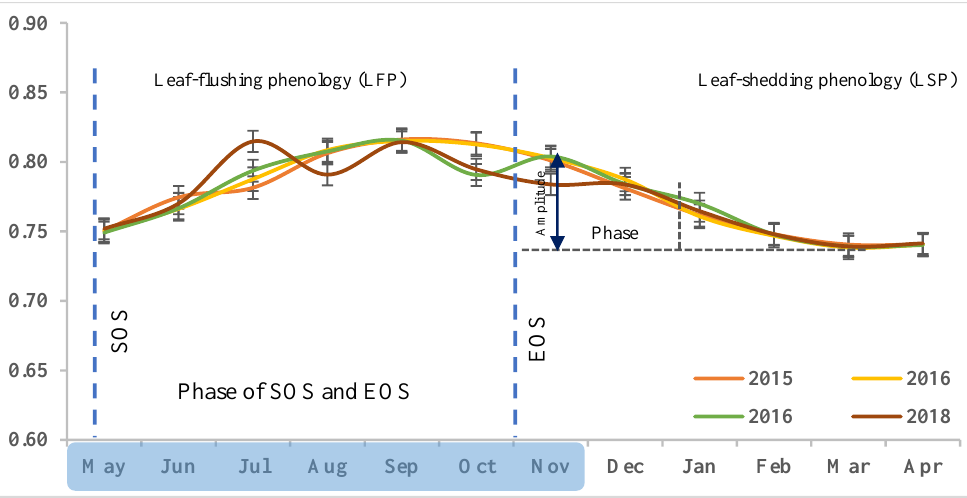
Figure 8. Fitted EVI profile of Landsat 8 OLI EVI composite data for evergreen forest. The average vegetation index profiles were generated from 10 geometry locations by assessing 40 profiles from 2015 to 2018. Figure 6 (bamboo), Figure 7 (rubber), and Figure 8 (evergreen) show the overlapping of average- fitted vegetation index profiles during SOS and EOS and the regular fluctuation of average EVI profiles of bamboo, rubber, and evergreen forest during the LSP stage (from December to April) in all 30 of the selected geometry locations from 2015 to 2018. The most distinguishable differences in the three vegetation cover indices were apparent in the LSP stage. The bamboo average-fitted vegetation index values were Min = 0.71 and Max = 0.83 from 2015 to 2017 and Min = 0.71 and Max = 0.84 in the LFP stage in 2018 (Figure 6). The fitted values for evergreen in the LSP stage reveal lower vegetation index values than those for bamboo in all selected phenology years (Figure 8). We found that evergreen had fitted average index values of Min = 0.63 and Max = 0.70 in the LFP stage from 2015 to 2018. The rubber plantation values (Min = 0.75 and Max = 0.80) were higher than the bamboo and evergreen forest values in the SOS to EOS season, and its vegetation index values were lower than bamboo and evergreen values during the LSP season (Figure 7). However, during the start of the LSP stage, bamboo vegetation index values (Max = 0.86 and Min = 0.83 from November to January) were greater than those of evergreen (Max = 0.71 and Min = 0.69) and rubber (Max = 0.80 and Min = 0.76) in the overall SOS and EOS or LFP period. The separation of fitted indices of bamboo, rubber, and evergreen phenological profiles in the mid-LSP stage is shown in Figure 9.